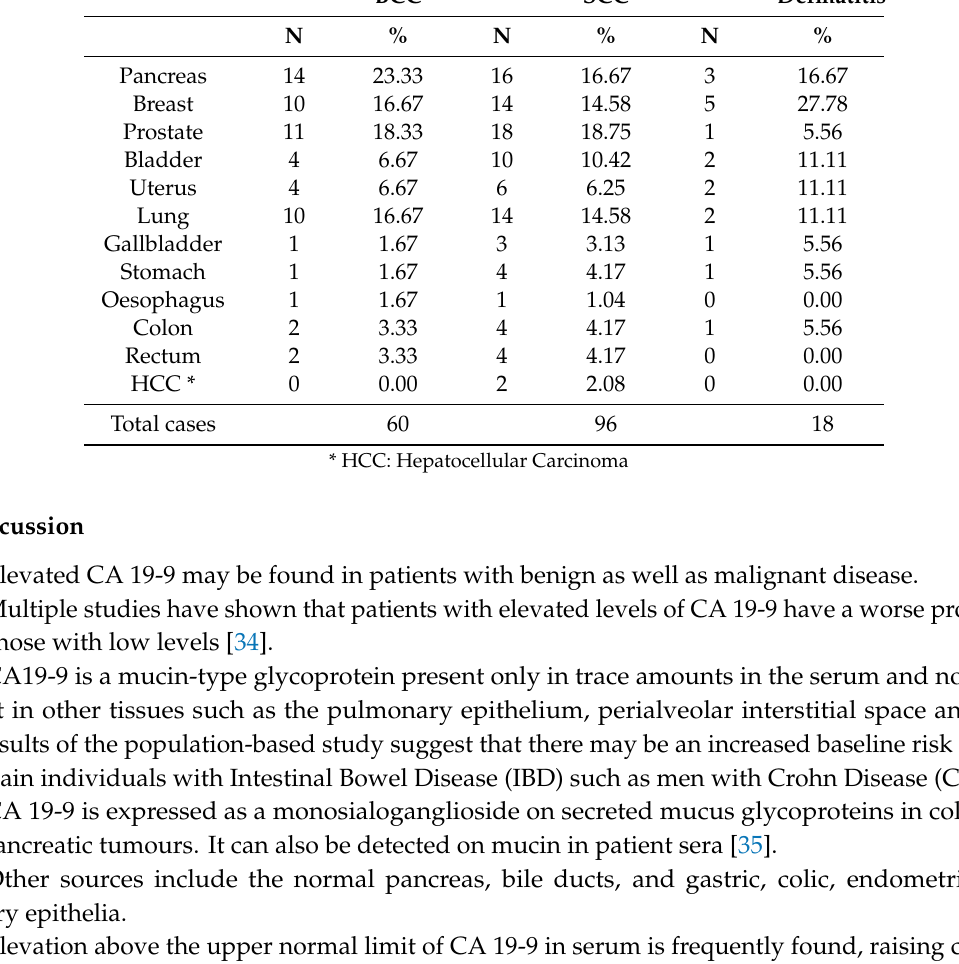
Table 4. Occult malignancies per site in NMSC and dermatitis with high levels of CA 19-9. BCC SCC